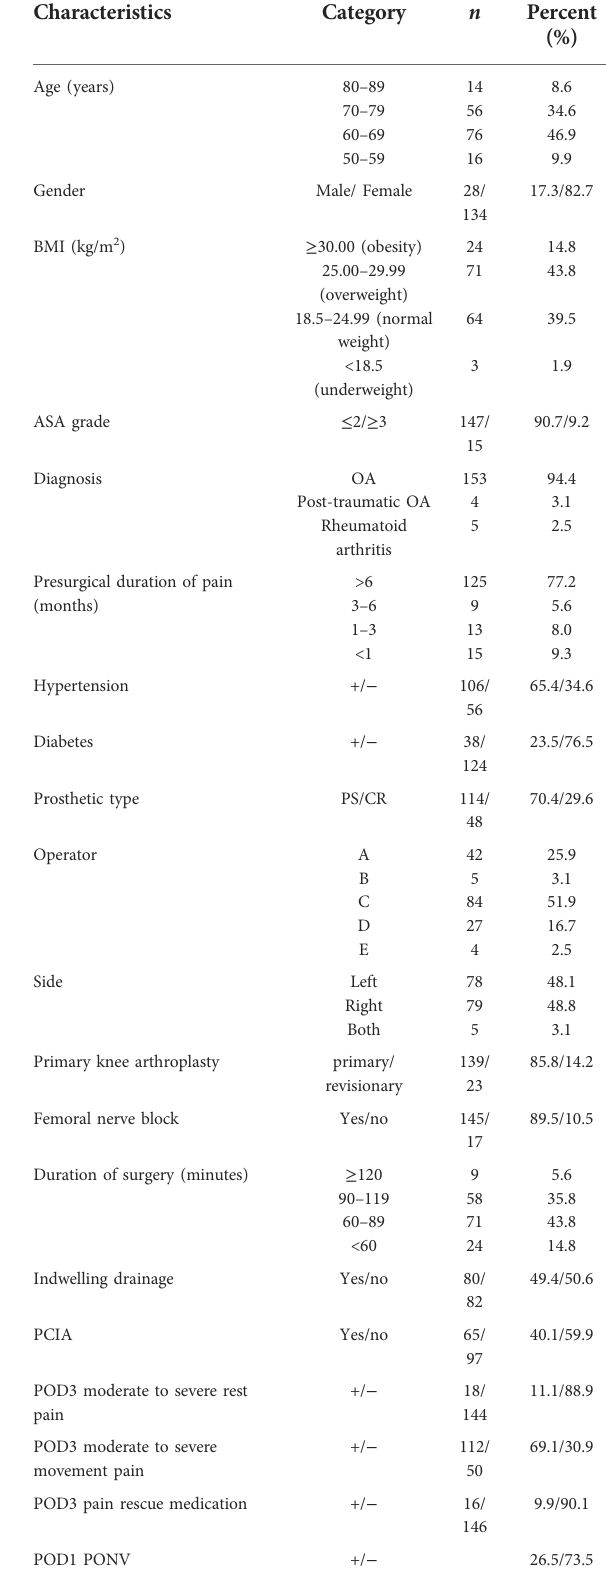
TABLE 1 Patients ’ characteristics (measurement data). TABLE 2 Patients ’ characteristics (categorical